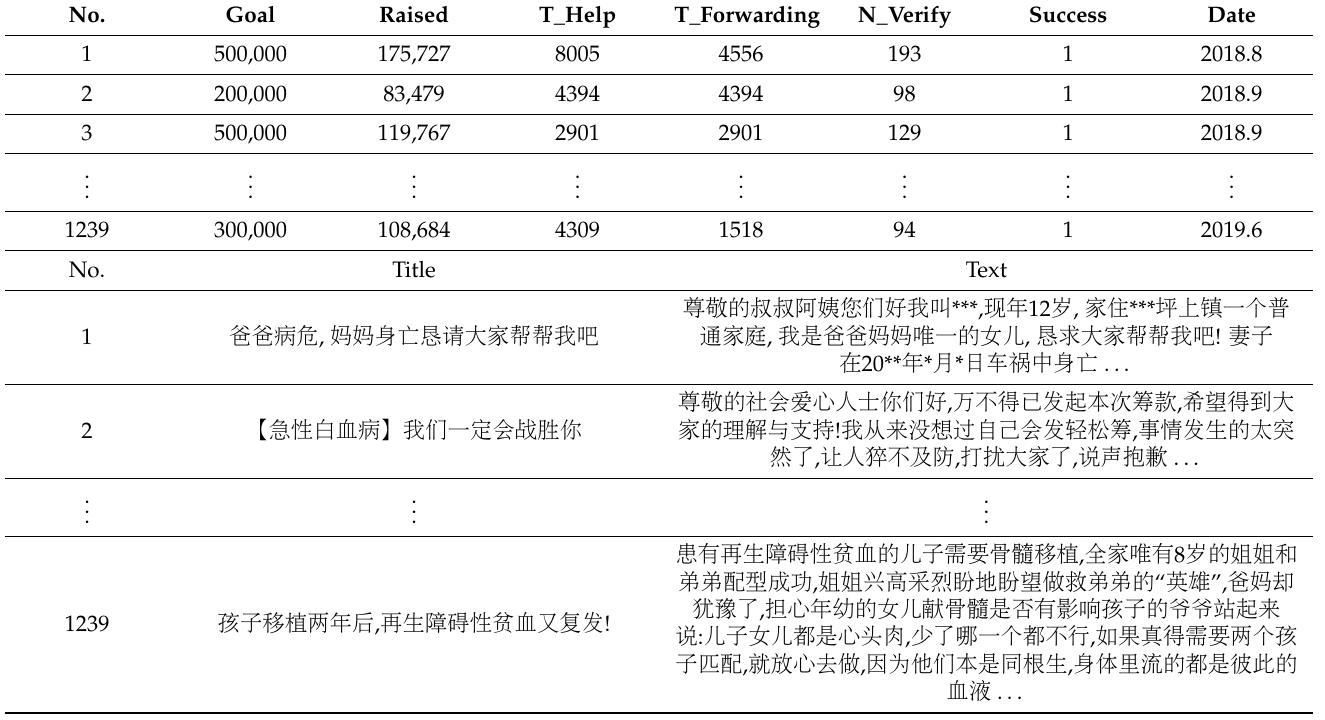
Figure 2. Sample data and basic structure of the project. Table 1. Data